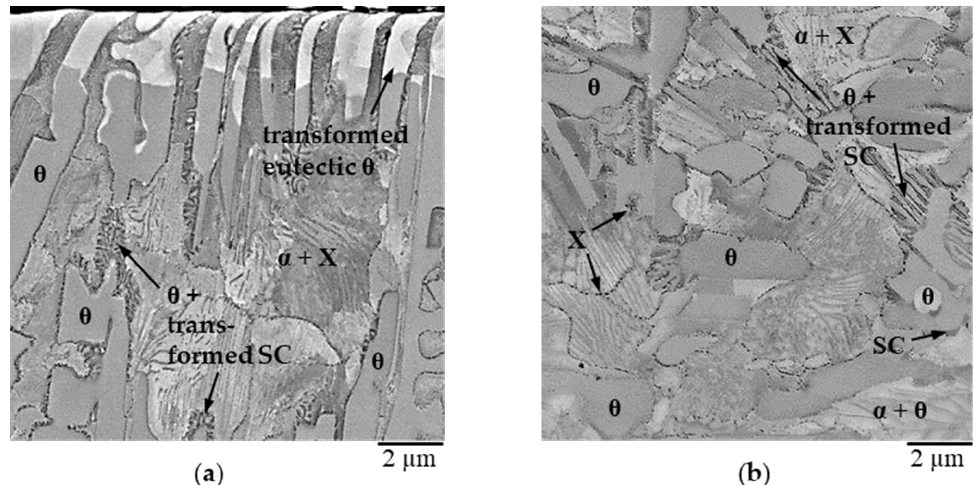
Figure 2. Cross-sectional SEM images (BSE contrast) of remelted T-2.5Si-0.2Mn-0.1Cu nitrided with K N = 0.1 at 540 °C for 4 h. Si nitride precipitations (X) in the intercarbidic regions are evident ( a ) near the decarburized surface and ( b ) at the end of the diffusion layer.